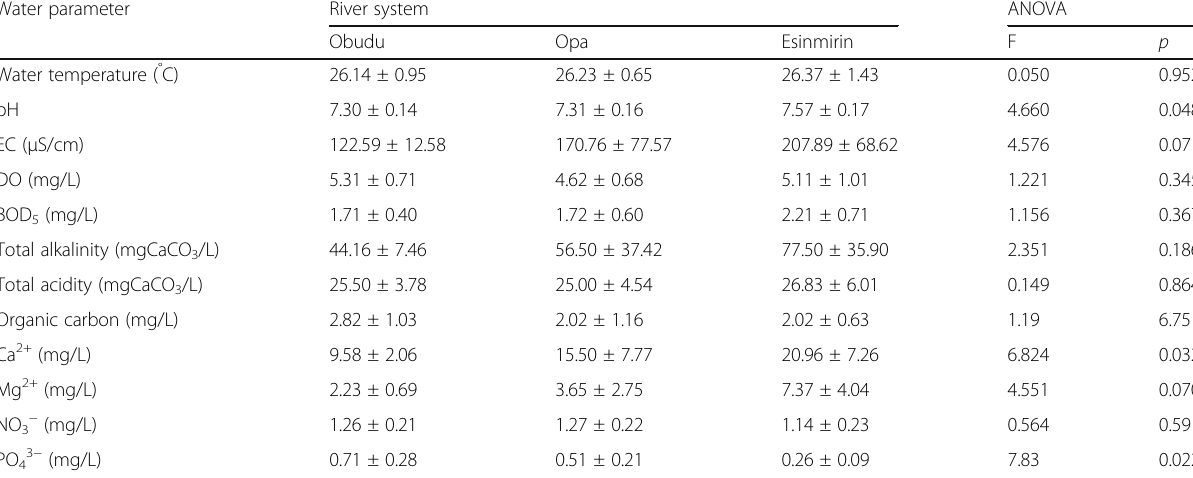
Table 1 Physico-chemical parameters of water in Opa Reservoir ’ s tributaries (September 2004 – July 2005) Water parameter